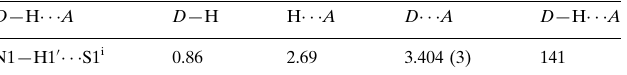
Hydrogen-bond geometry (A˚ , (cid:2)